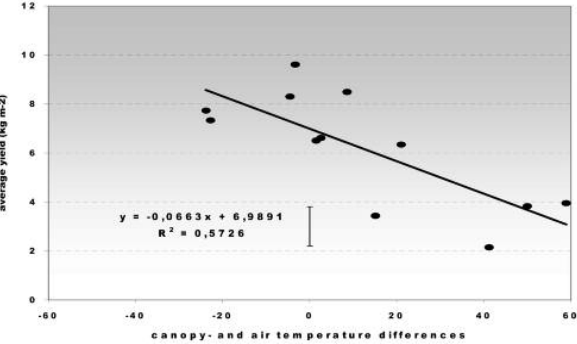
Figure 4. Correlation between canopy- air temperature differences and yield quantity